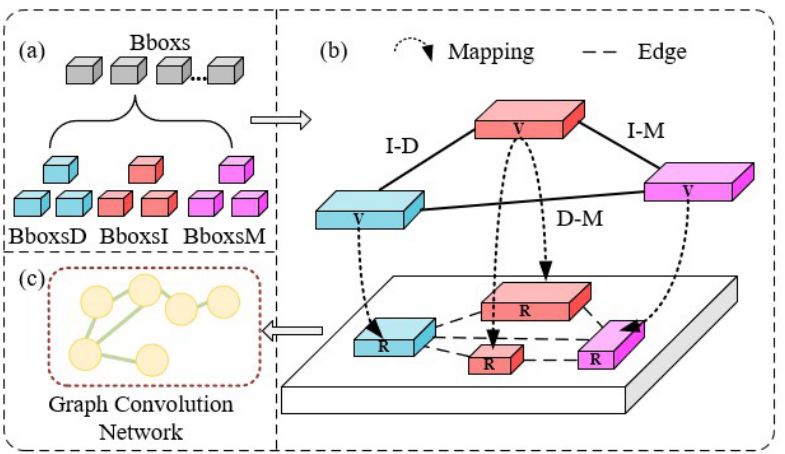
Figure 6. Architecture of the PFT model. ( a ) shows that the box contains category information and feature information; ( b ) shows a mapping mechanism; ( c ) shows the process of using graph neural network for the appearance geometric reasoning of real